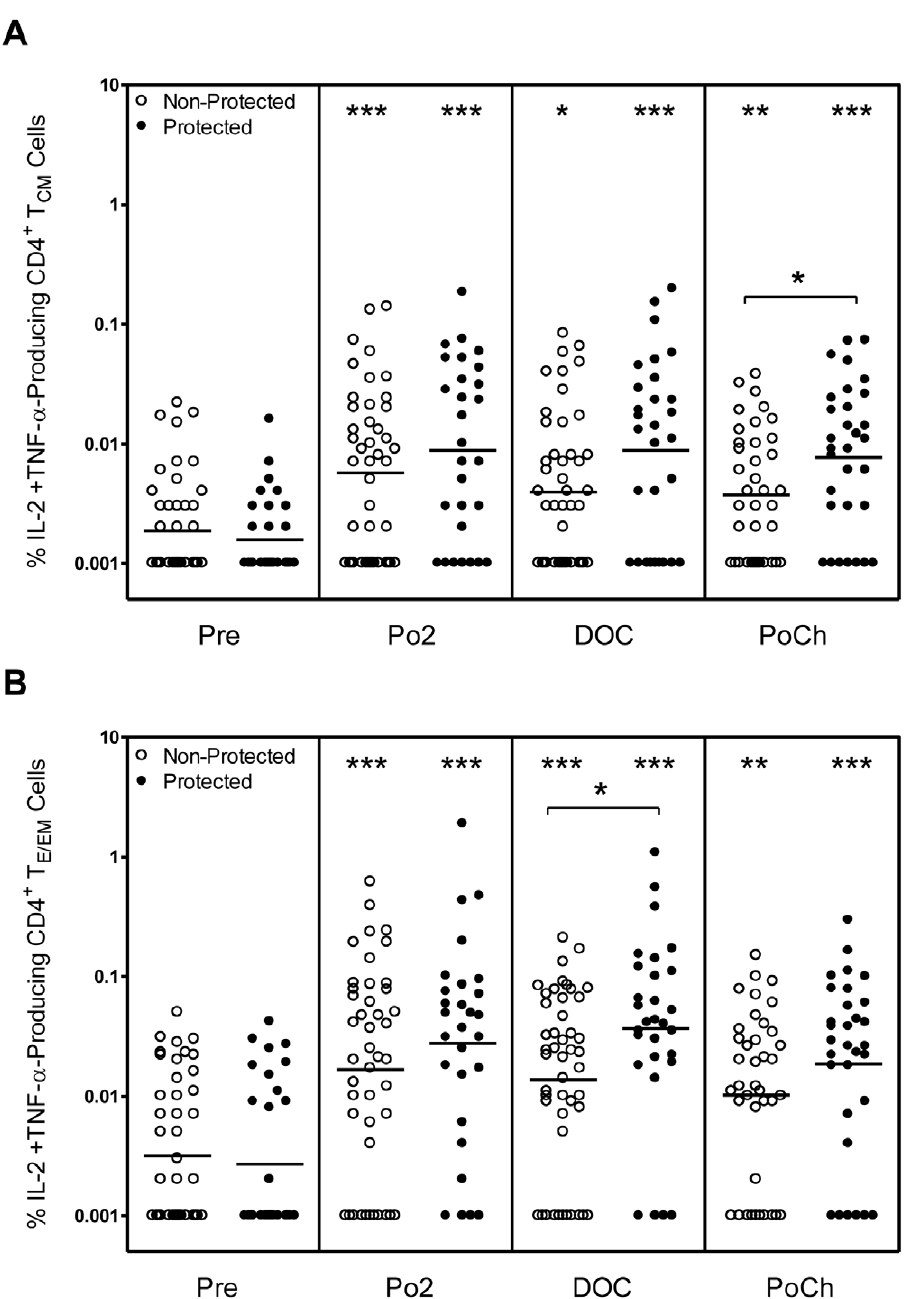
Figure 6. Frequency of CD4 + T CM and T E/EM cells producing both IL-2 and TNF- a upon recall with CSP peptides. PBMC were obtained at the indicated time points from RTS,S-immunized subjects and were incubated as described in Fig. 3 with CSP peptides as described in Methods. Cells were then analyzed as described in the legend to Fig. 1. The values are plotted as the % [A] CD4 + T CM cells producing both IL-2 and TNF- a and [B] CD4 + T E/EM cells producing both IL-2 and TNF- a for protected (closed symbol) and non-protected (open symbol) subjects. Statistically significant differences between pre-immune and post-vaccination time points are indicated at the top of the graph. Statistically significant differences between values for protected and non-protected subjects are as indicated within the body of the graph. *p , 0.05; **p , 0.01; ***p , 0.001. doi:10.1371/journal.pone.0020775.g006 PBMC contain both CSP-specific CD4 + T E/EM and CD4 + T CM cells and that both subsets can be re-stimulated in vitro with CSP peptides to generate strong IL-2 responses. Notably, not only the frequencies, but also the total number of IL-2-producing CD4 + T E/EM and CD4 + T CM cells, were higher for protected as com- pared to non-protected volunteers. This result is in agreement with protected subjects. The lack of responsiveness in some subjects